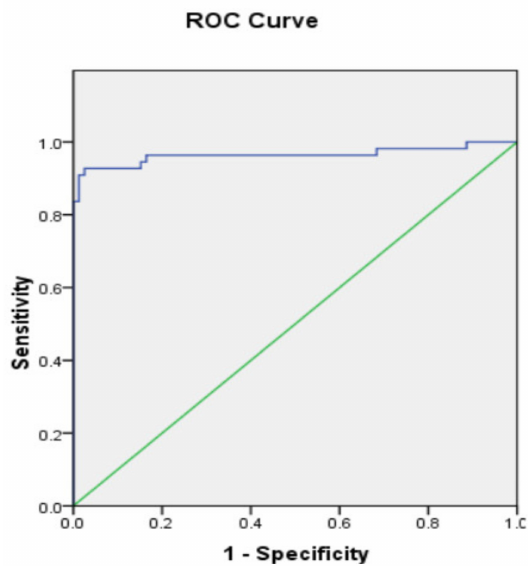
Figure 1. Receiving operating curve (ROC) of the multivariate analysis for HCC development in NASH patients. Area under the curve (AUC) was 0.964 (95% CI =